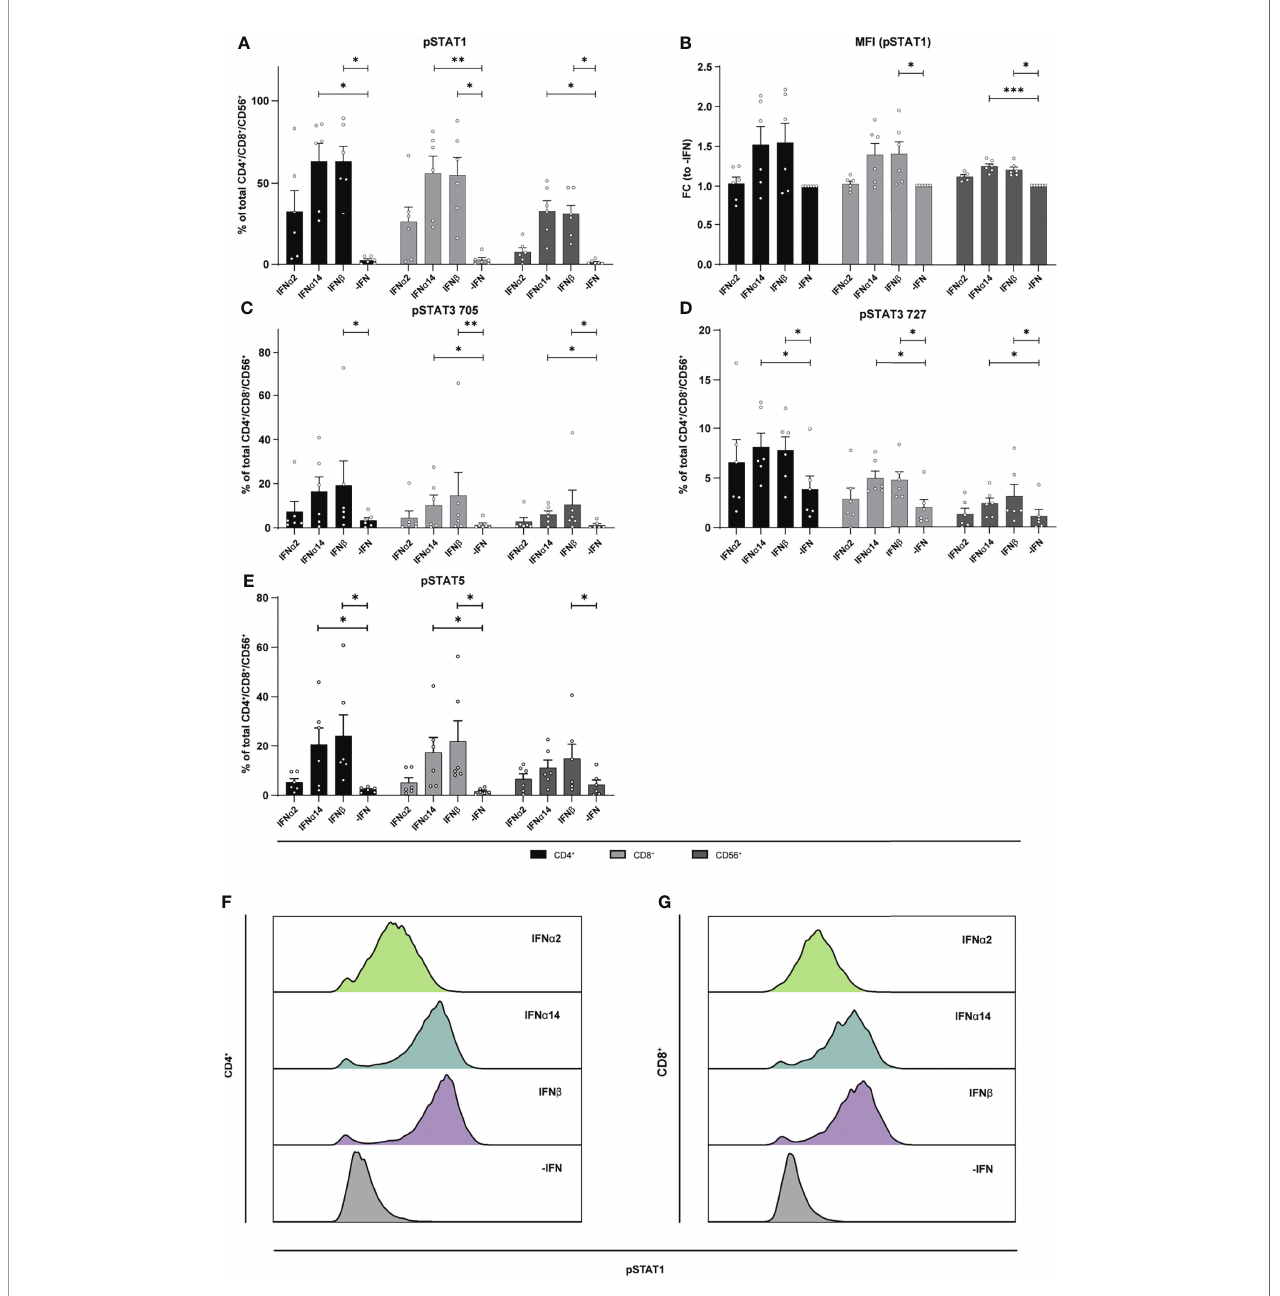
FIGURE 6 | Phosphorylation of STAT molecules after IFN stimulation in LPMCs. LPMCs were stimulated with 2000 U/ml IFN a 2, IFN a 14, IFN b , or without IFN (-IFN) in presence ofthe surface markersanti-CD3, anti-CD4, anti-CD8, anti-CD56, and theviability marker FVD.Cells were then fi xated andpermeabilized for phospho fl ow analysis with anti-STAT1 pTyr702, anti-STAT5 pTyr694, anti-STAT3 pTyr705, and anti-STAT3 pSer727. (A) Frequencies of phosphorylated STAT1, (B) mean donor-speci fi c fold changes of MFI (pSTAT1) (C) frequencies of phosphorylated STAT3 pTyr705, (D) STAT3 pSer727, and (E) STAT5 on CD4 + , CD8 + T, and NK cells. Mean values ± SEM are shownfor n=6. Statistical analyses between the treated groups within a cellpopulation were doneby using Friedman test and Dunn ’ s multiplecomparisontest. ***,P < 0.001; **, P < 0.01; *,P < 0.05. (F) Representative histogramsofphosphorylatedSTAT1 expression by unstimulatedorIFN-stimulated CD4 + and (G) CD8 + T